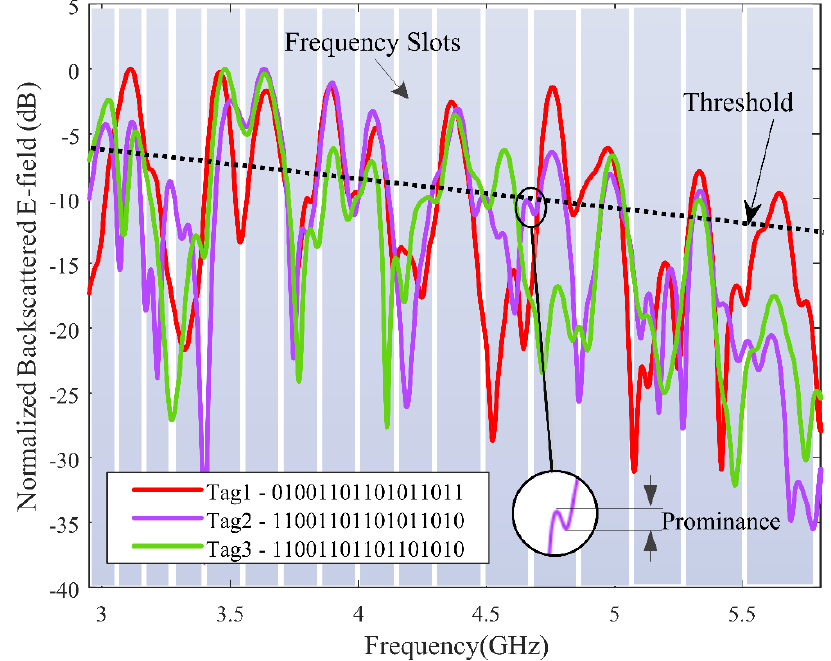
Figure 12. Measured frequency response of the fabricated tags with its ID.